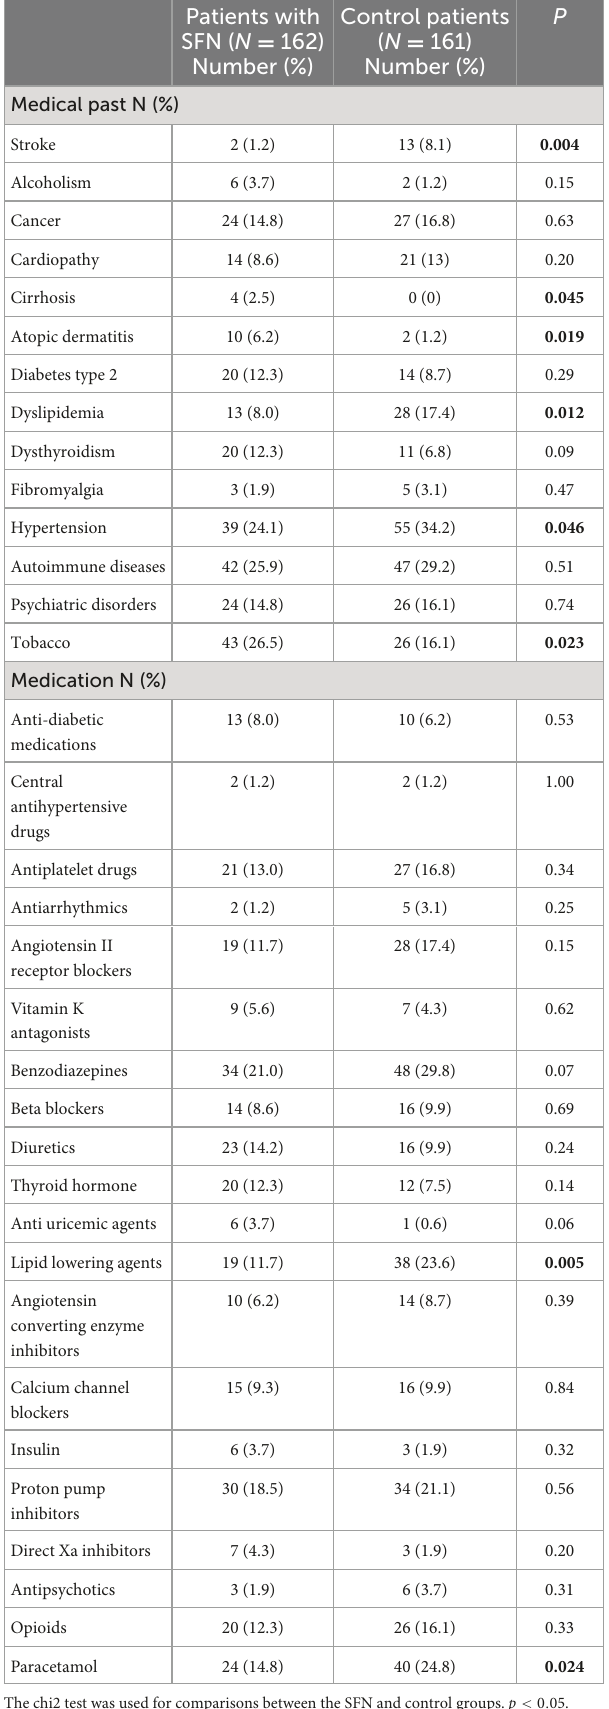
TABLE 2 Medical history and treatments in the group of patients with SFN and the control group. Patients with SFN ( N = 162) Number